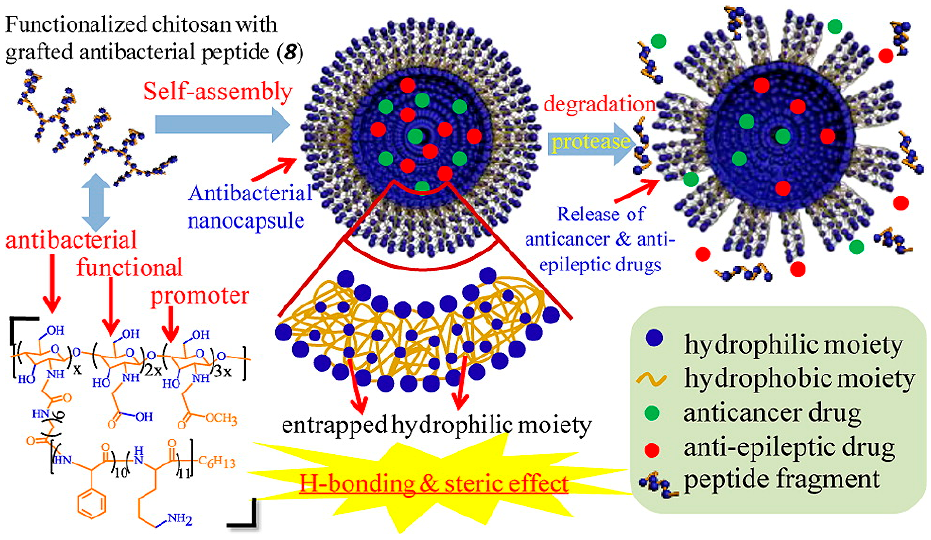
Figure 5. Antimicrobial polymer vesicles as drug carrier self-assembled from the antibacterial polypeptide-grafted chitosan [97] (Reprinted with permission from [97]).